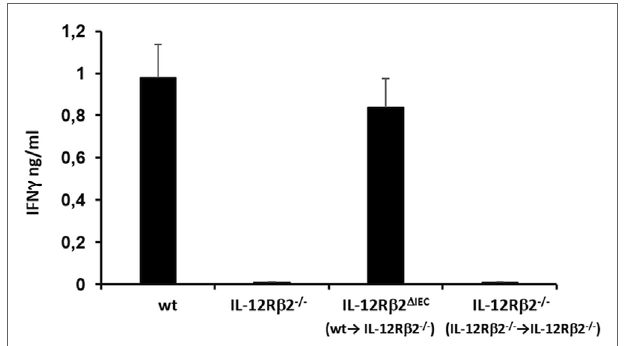
FigUre 4 | Bone marrow (BM) transplant restored in vivo IL-12-mediated production of IFN γ in IL-12R β 2 − / − mice. Systemic (i.p.) administration of IL-12 induced the production of IFN γ by immune cells via IL-12/12R ligation. This response was absent in IL-12R β 2 − / − mice; the pattern was different in chimeric mice generated by BM transplant from wild-type (wt) mice into IL-12R β 2 − / − mice. At week 8 posttransplant the recipient mice that lacked IL-12R β 2 exclusively in intestinal epithelial cells (IECs) (IL-12R β 2 ∆ IEC ) showed a physiologic production of IFN γ following ip. administration of IL-12 demonstrating a successful BM engraftment. By contrast, IL-12R β 2 − / − recipients that were transplanted with BM from syngeneic IL-12R β 2 − / − did not respond to IL-12 administration. Statistical analysis (seven mice/group) was carried out by (ANOVA) Wilcoxon rank test. (*) indicates statistical difference p <